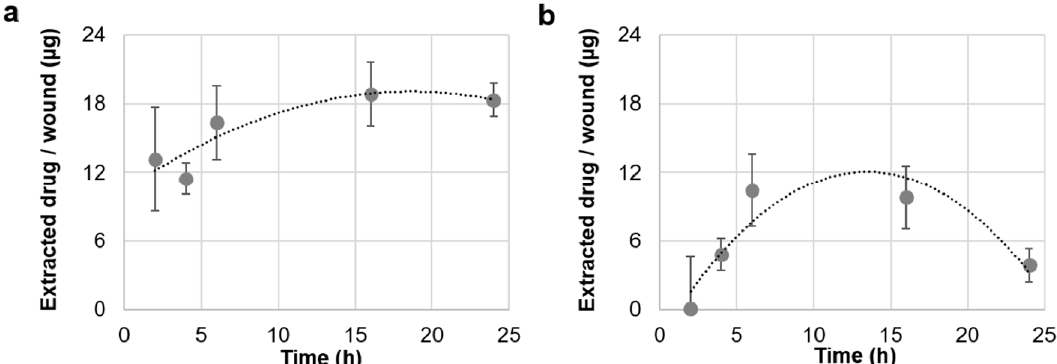
Figure 2. Time-dependent concentration of ciprofloxacin into wound tissue after the topical application of ciprofloxacin-loaded foils ( a ) and nanofibers ( b ). Ciprofloxacin in wound tissue extracts was measured by means of a fluorescence microplate reader and drug concentration was calculated from standard curves. Means and standard deviations from three independent experiments using skin from three different donors are reported.